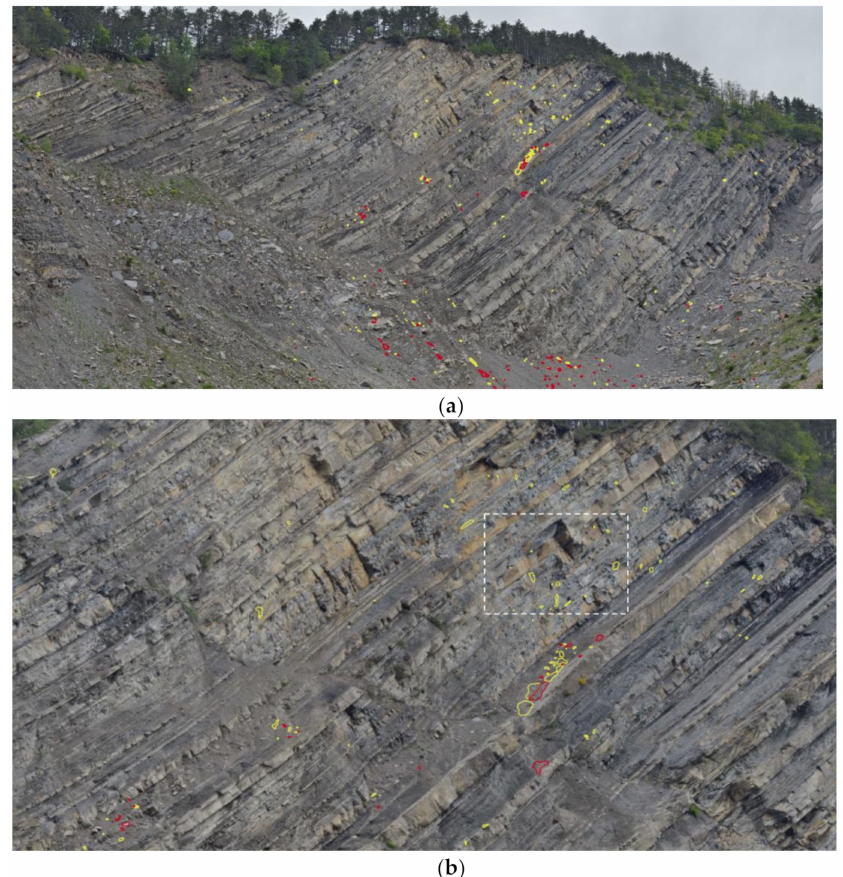
Figure 7. Gigapixel image with all rockfalls detected during the three days monitoring campaign: ( a ) 2D Change Detection (2D-CD) along the Poggio Baldi cliff with detached rock falls (yellow) and debris removal (red); ( b ) Zoom of the most active sector during the monitoring